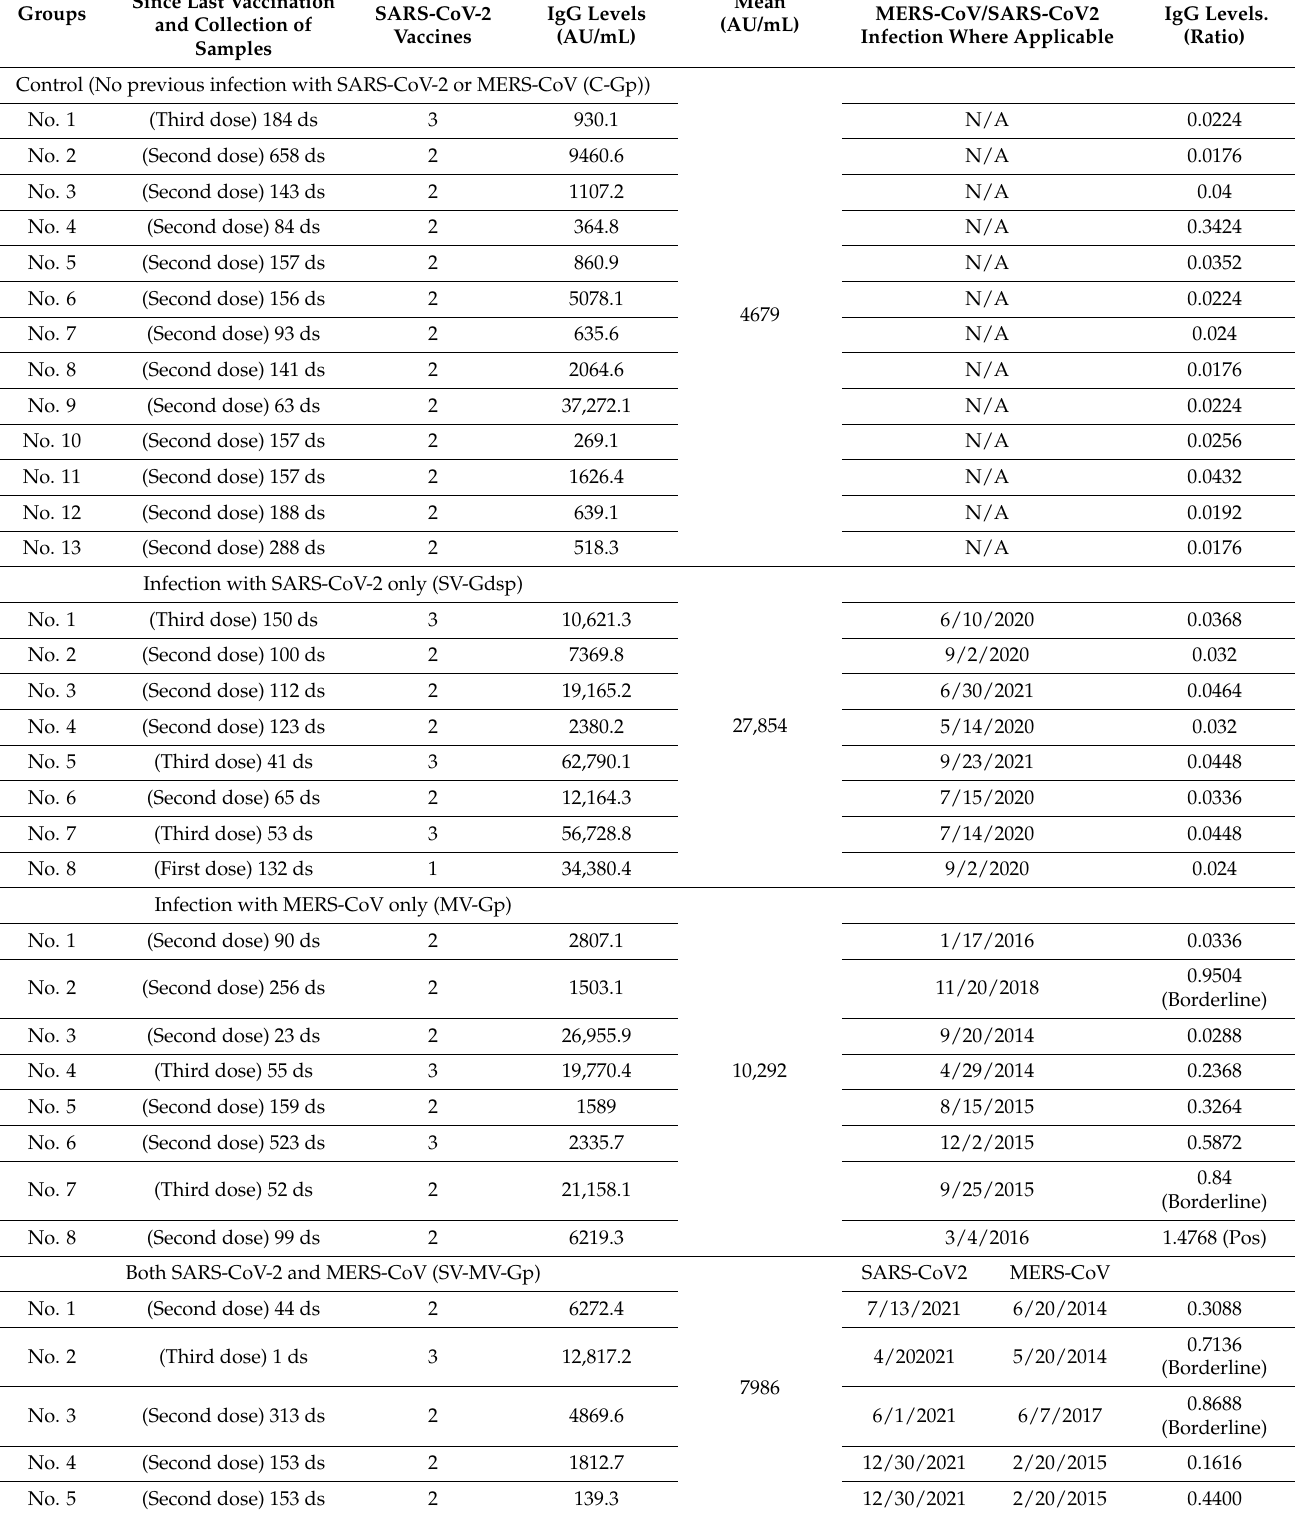
Table 2. SARS-CoV-2 IgG and MERS-CoV IgG levels across the various groups.